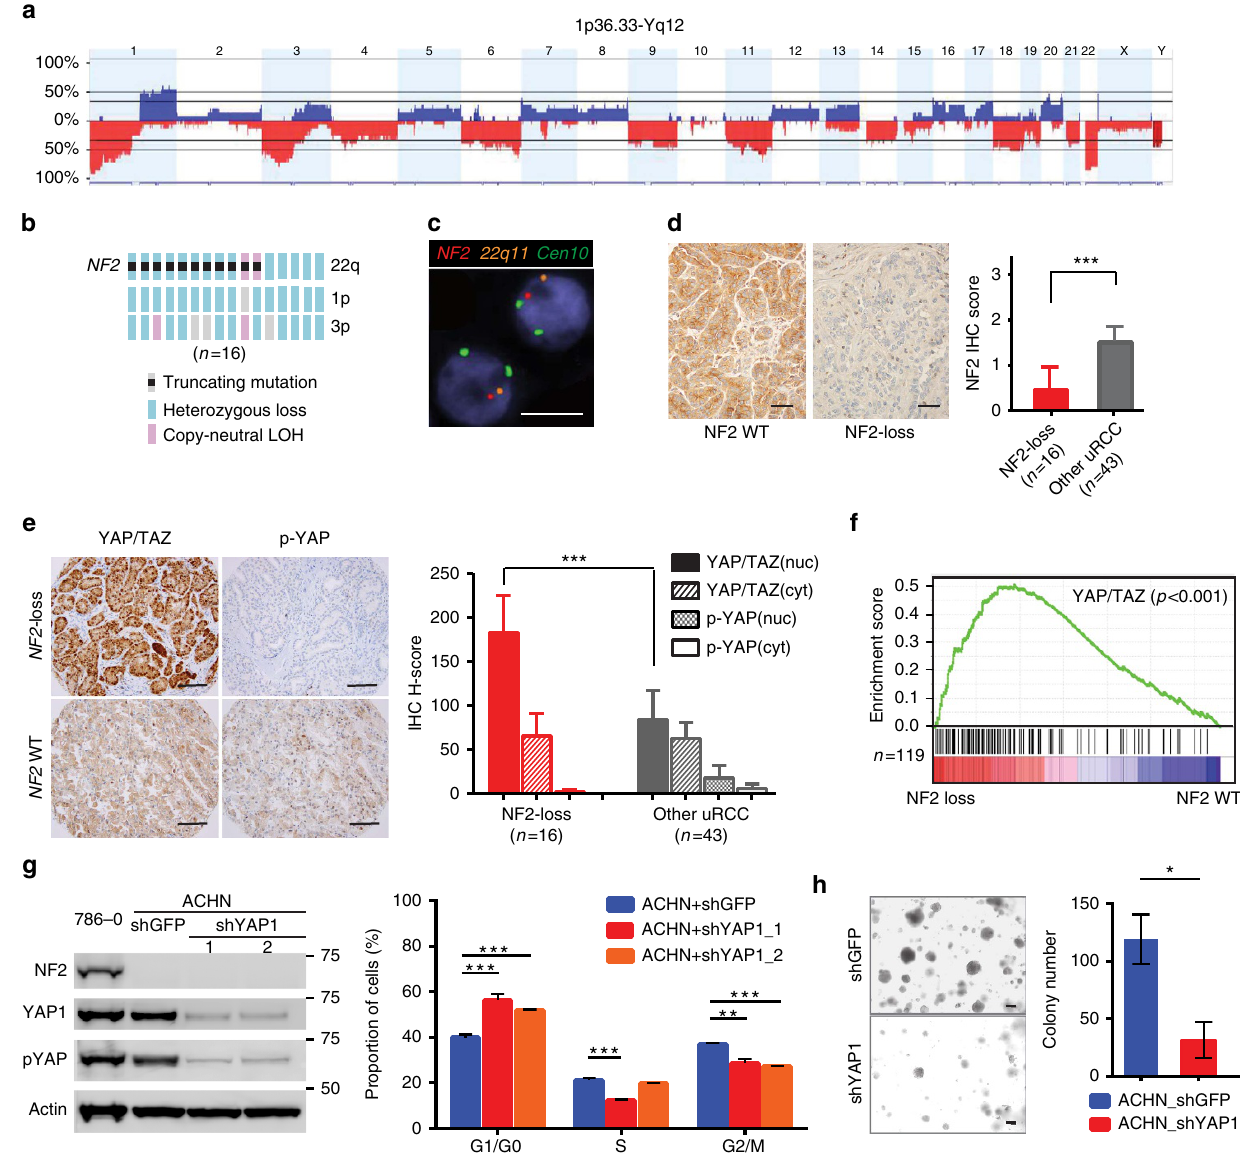
Figure 2 | Molecular characterizations of the NF2 loss uRCC subset. ( a ) Genome-wide frequency plot of DNA copy-number gains (blue) and losses (red) across all chromosomes was determined by OncoScan SNP assay in 15 of the 16 uRCC tumours carrying NF2 mutations and/or 22q loss. The y axis denotes frequencies of alteration in individual chromosomal regions. Copy-neutral loss of heterozygosity (CN-LOH) is shown in Supplementary Fig. 1. ( b ) Summary of NF2 mutations and frequent ( 4 50%) arm-level copy-number alterations (22q, 1p and 3p) detected by sequencing and SNP array analyses of the NF2 loss subset ( n ¼ 16). Truncating mutations include nonsense mutations, insertions or deletions that alter the reading frame and splice-site mutations.